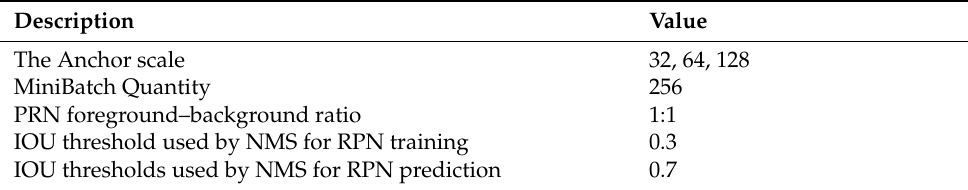
Table 1. RPN training parameters